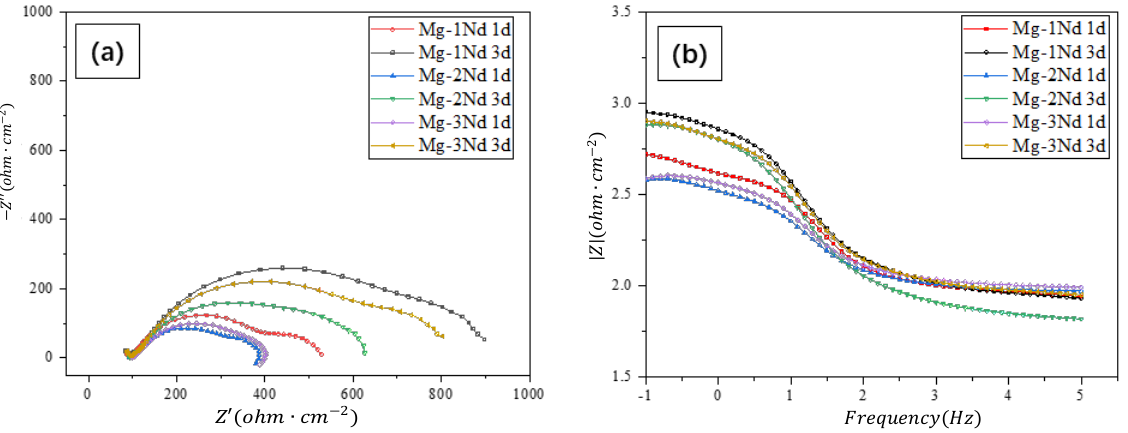
Figure 7. ( a ) Nyquist diagram of Mg-Nd alloy in F state; ( b ) relationship between impedance and frequency in Bode diagram.